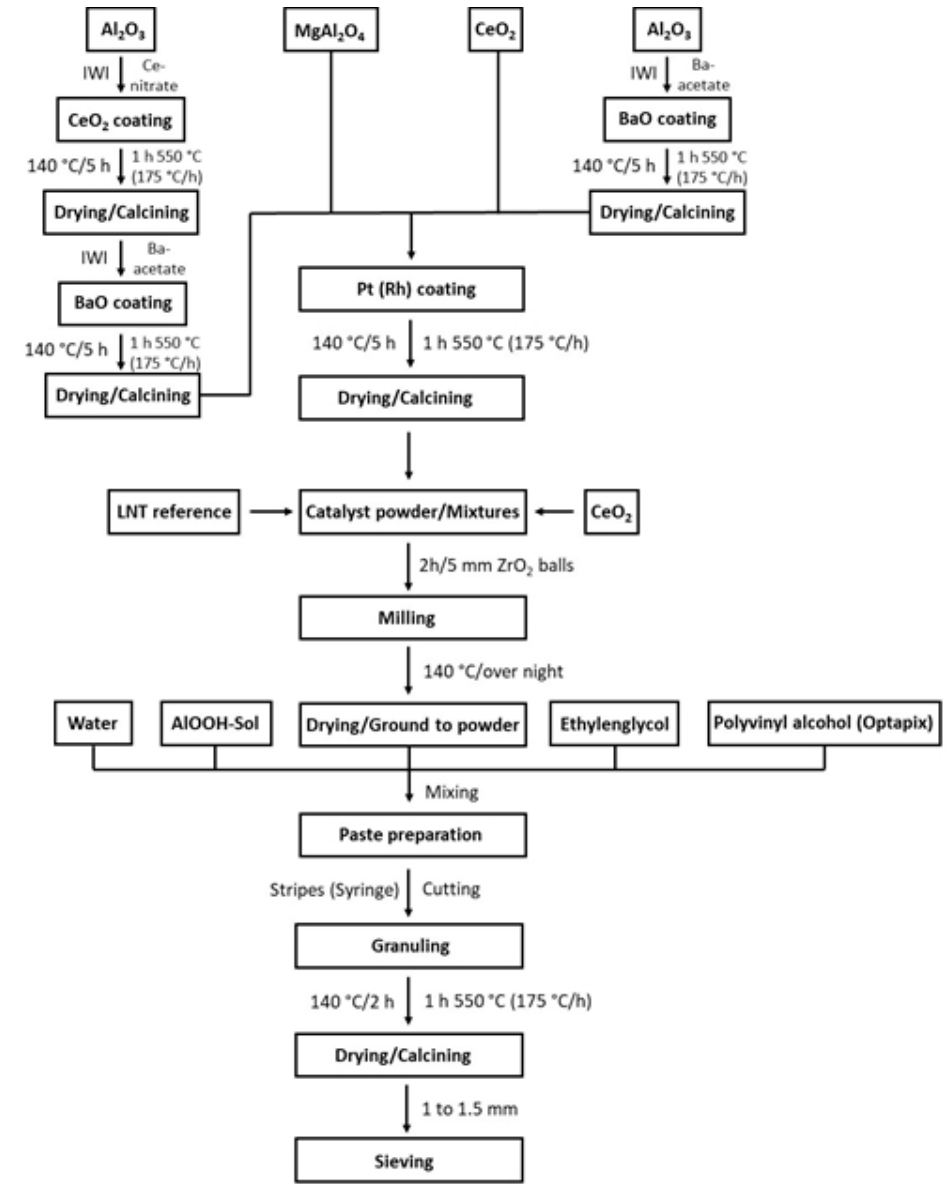
Figure 7. Flow chart of the catalyst.